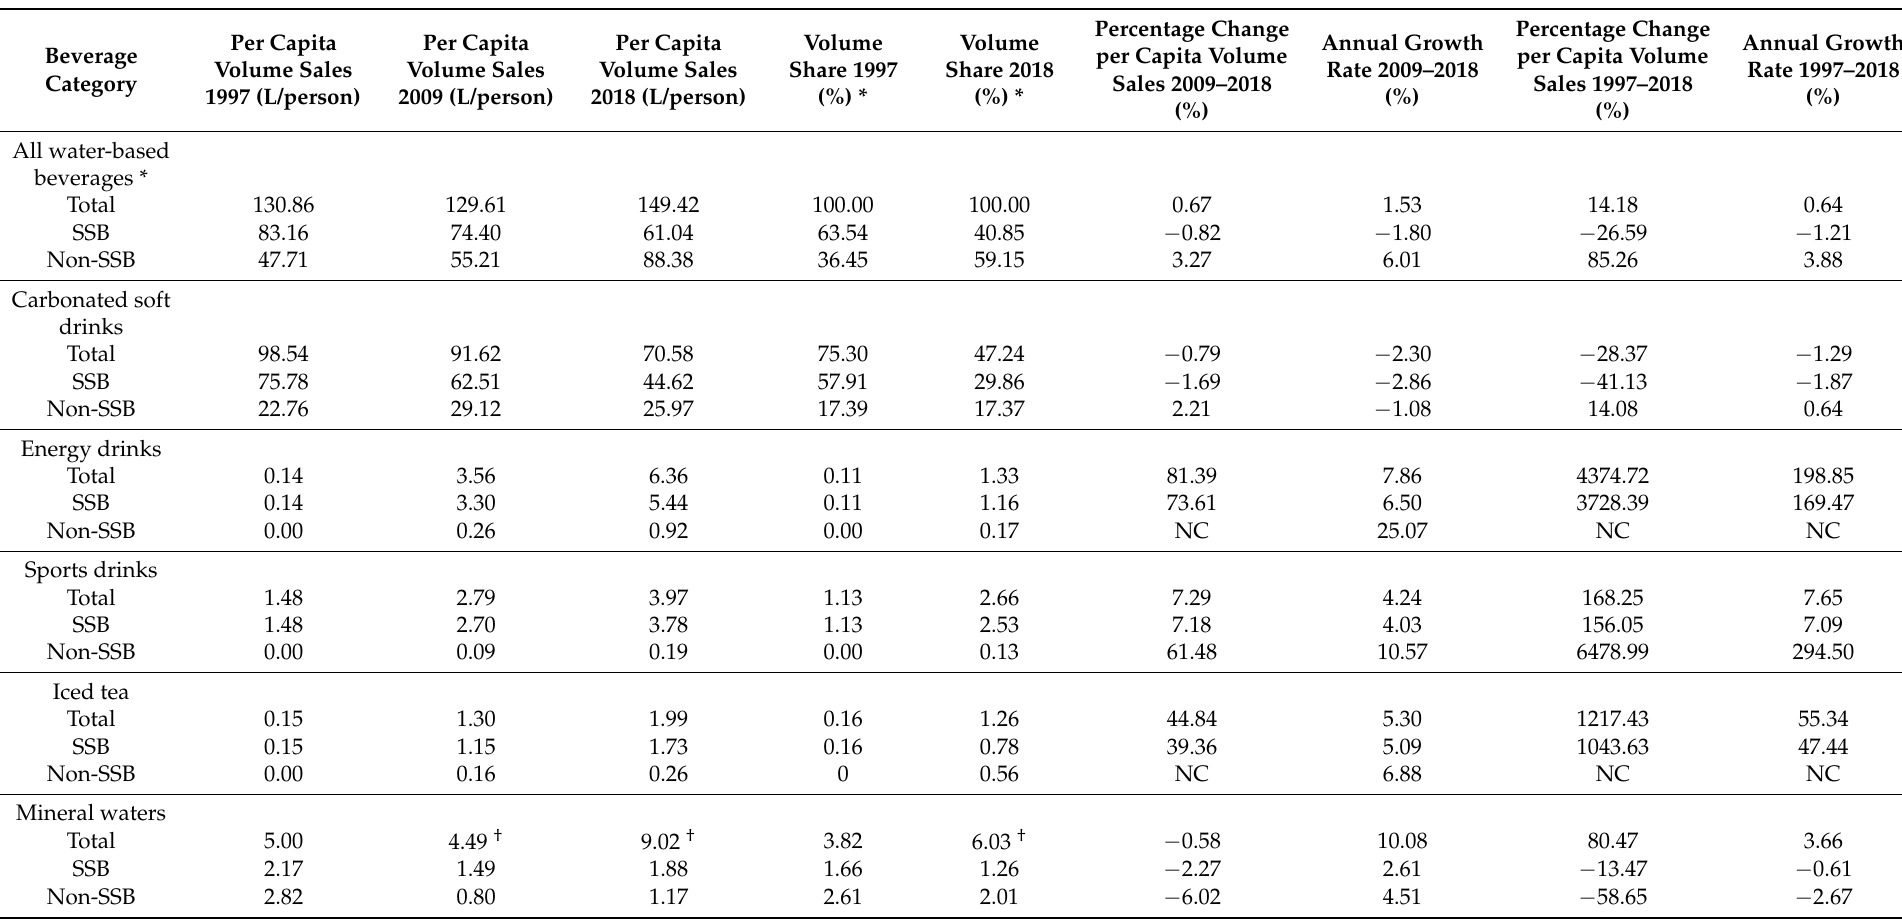
Table 1. Trends in volume sales of water-based beverages between 1997 and 2018. * Total may not equal sum of sugar-sweetened beverages (SSB) and non-SSB categories due to rounding